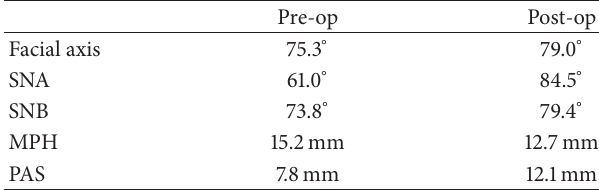
Table 1: Overnight polysomnography (PSG) before and after surgery.